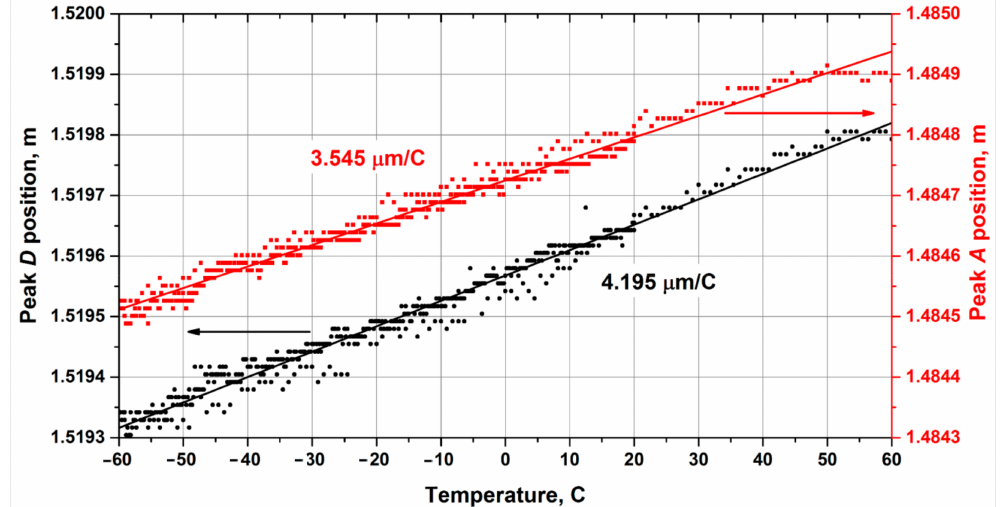
Figure 11. Displacement of coordinates of the beginning (A) and the end (D) of the IOM peaks. Locations A,D are presented at Figure